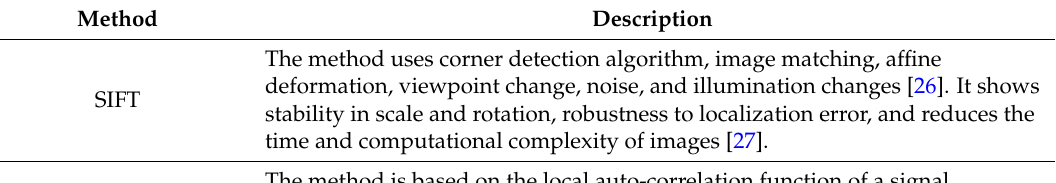
Table 4. Comparison with methods used in edge detection.